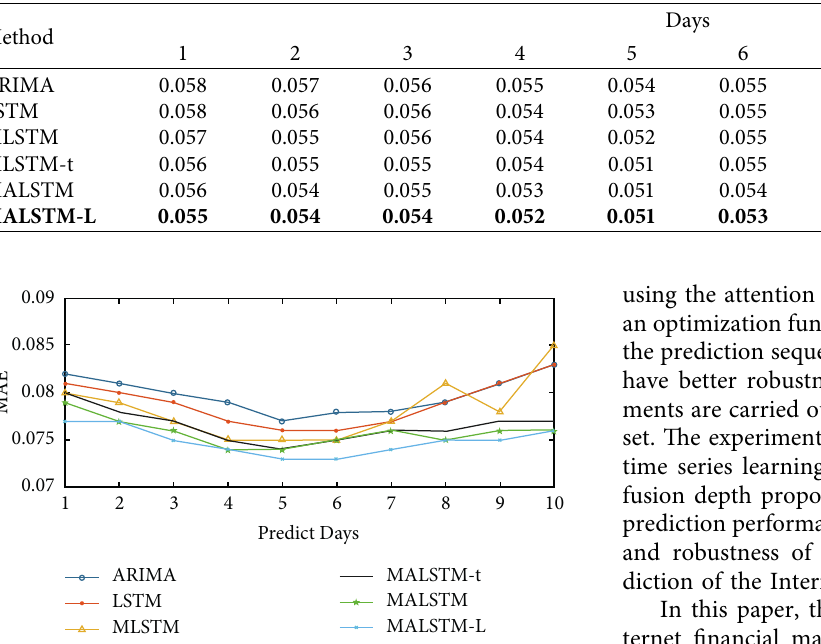
Table 4: The MAE results of the market counts prediction in the next ten days.